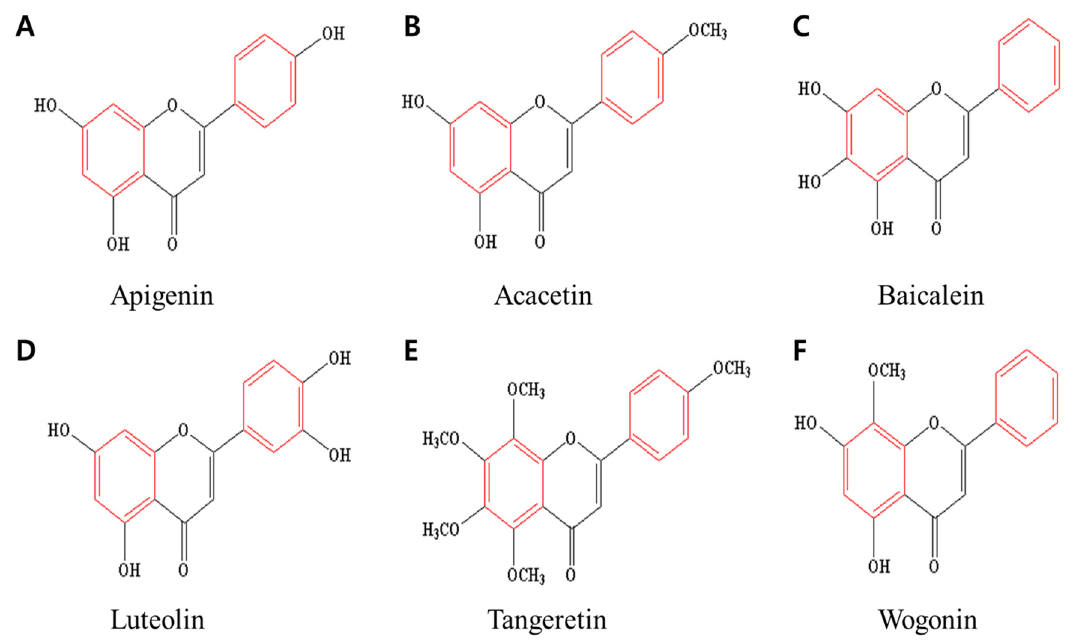
Figure 2. Chemical structures of flavones ( A ) apigenin, ( B ) acacetin, ( C ) baicalein, ( D ) luteolin, ( E ) tangeretin, and ( F ) wogonin.